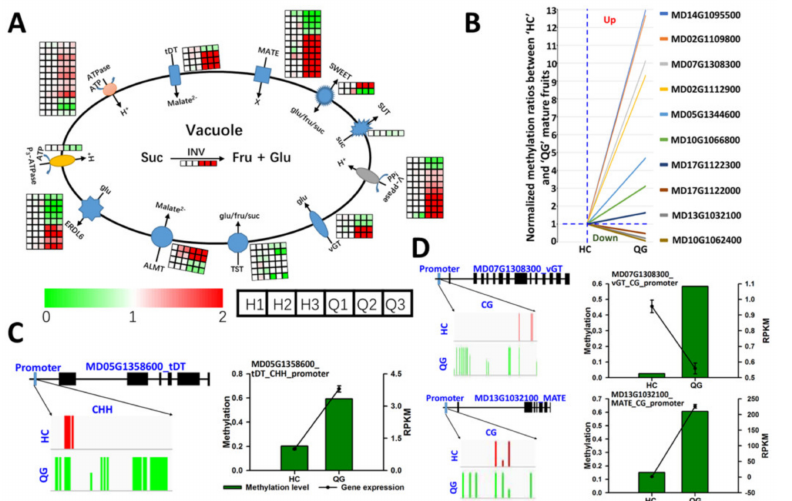
Figure 4. Expression and methylation levels of genes involved in soluble sugar and organic acid transport into vacuoles. ( A ) Differentially expressed genes involved in organic acid and soluble sugar transport between ‘HC’ (left 3 boxes) and ‘QG’ (right 3boxes) mature fruits. ( B ) Cluster analysis of differentially methylated genes. ( C , D ) IGV snapshots of DNA methylation and gene expression in ‘HC’ and ‘QG’ mature